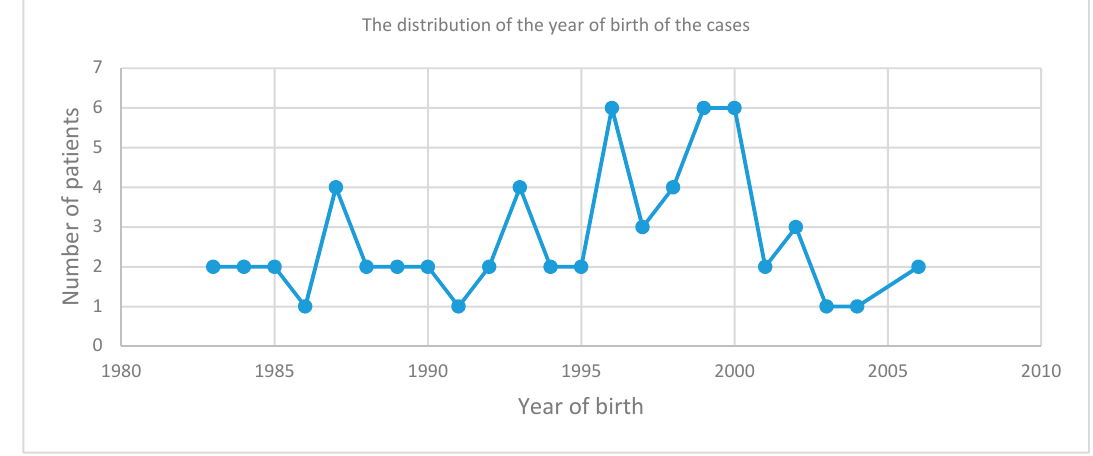
Figure 6. The distribution of the year of birth of the pediatric differentiated thyroid cancer cases in IOCN diagnosed in the period 2000–2018.